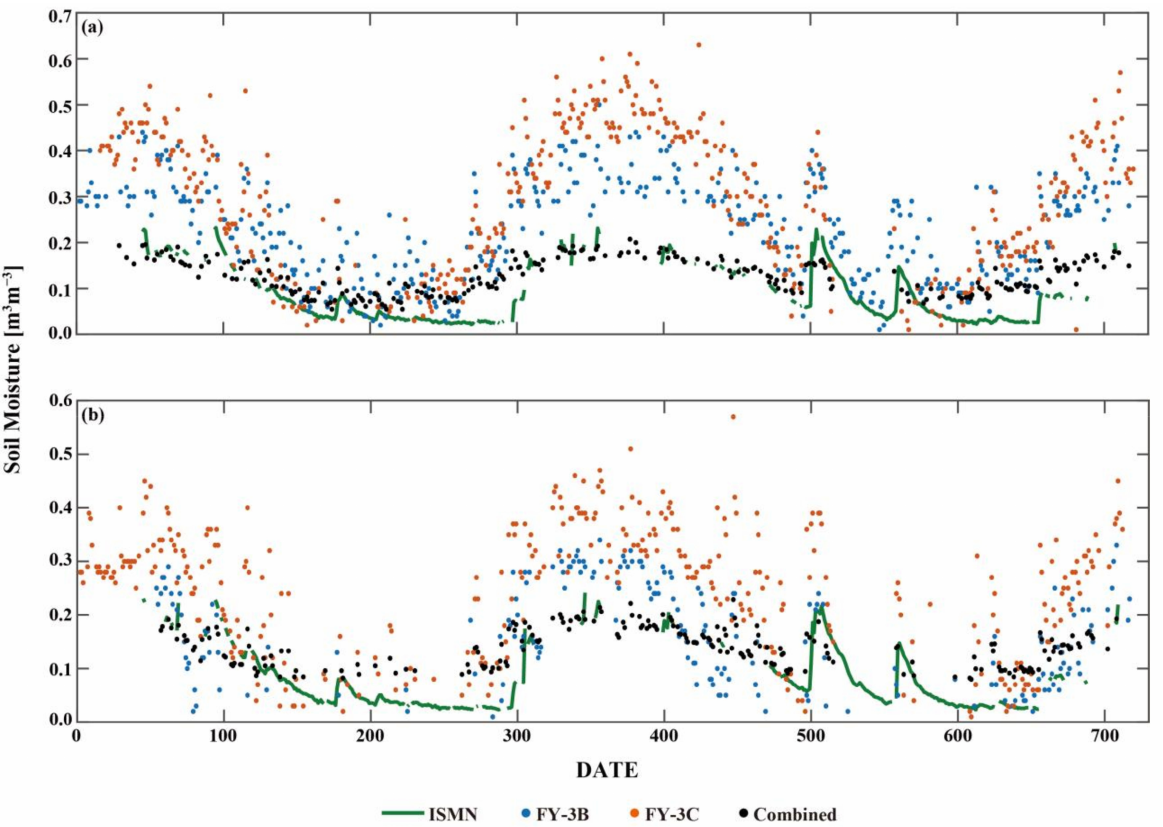
Figure 8. Time series (118 ◦ W, 42 ◦ N) of a chosen pixel showing an example of the SM from FY-3B LPRM (blue), FY-3C LPRM (orange), and the combined data (black) over the same in situ site (green) for ( a ) descending and ( b ) ascending estimates (unit: m 3 m − 3